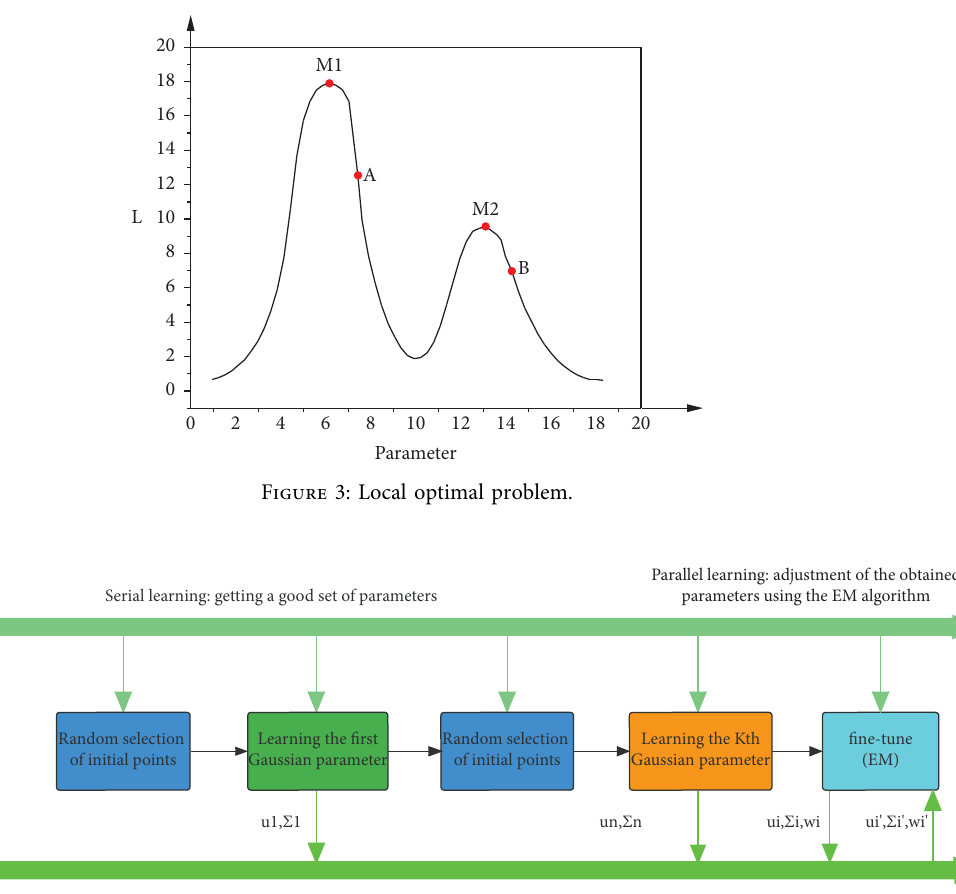
Figure 4: Improved structure block diagram of EM